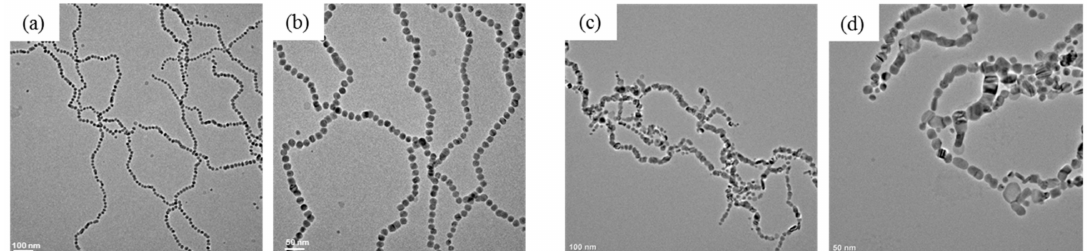
Figure 4. TEM images of PS–Co NPs synthesized with the concentration of PS–NH 2 ( M n = 4500 g/mol) at 2.5 mM, only with different concentration of cobalt carbonyl (C Co ): ( a , b ) C Co = 7.3 mM, D = 18.8 ± 1.3 nm; ( c , d ) C Co = 58.4 mM, D = 26.6 ± 7.9 nm. The PS–Co NP samples were prepared on TEM grid from the respective NP dispersion in DCB. The mean size and standard deviation were obtained from a sample of around 200 NPs using ImageJ